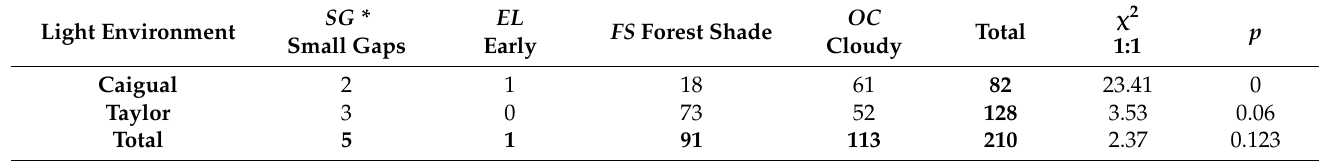
Table 1. Counts of light environments used during display sequences.